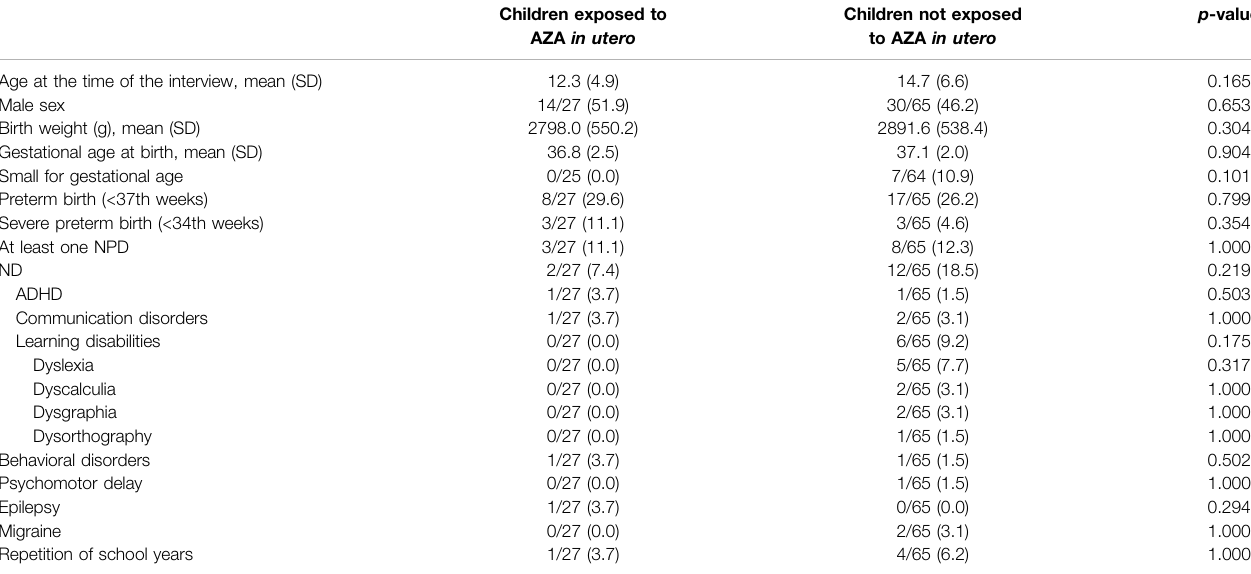
Children exposed to Children not exposed AZA in utero to AZA in utero